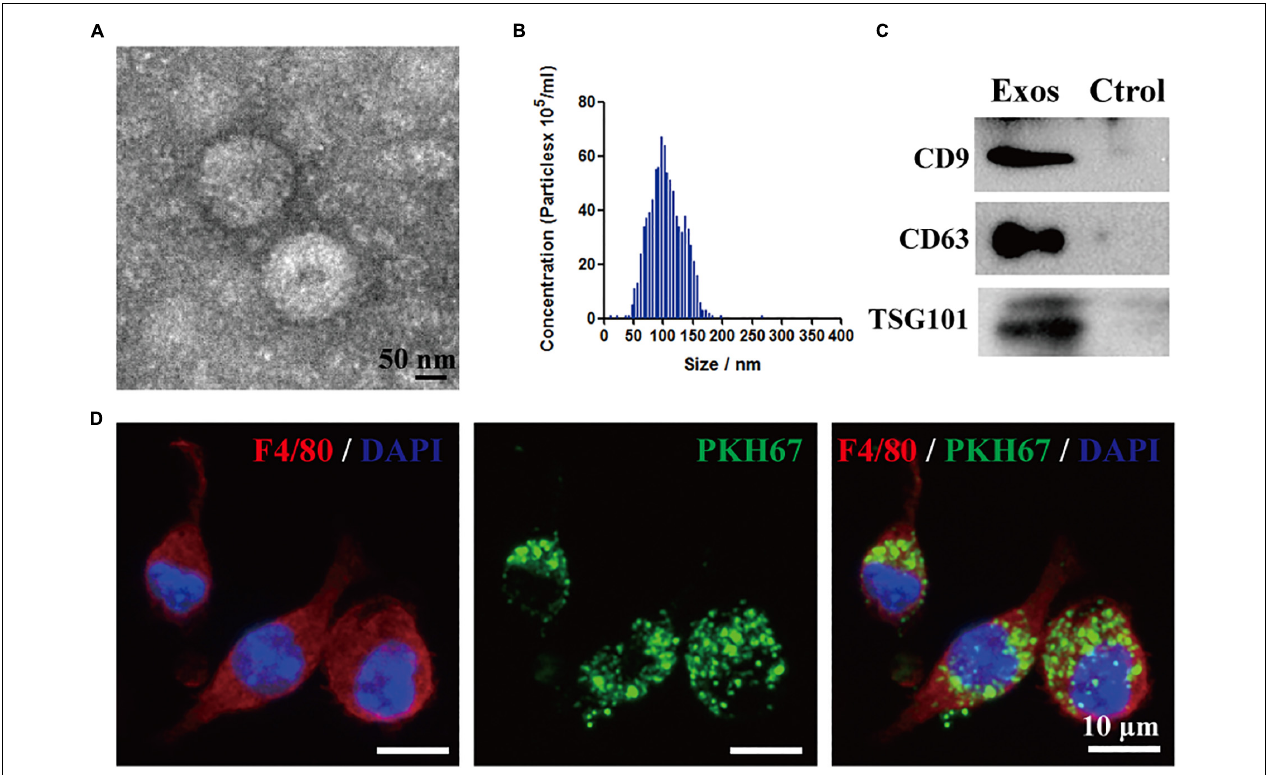
FIGURE 1 | Identification of bone marrow mesenchymal stem cell-derived exosomes (BMSC-Exos) and BMSC-Exos uptake by macrophages in vitro . (A) Representative transmission electron microscopy (TEM) image of Exos. Scale bar = 50 nm. (B) Nanoparticle tracking analysis (NTA) of the Exos diameter and particle number. (C) Western blotting analysis of the exosome-specific markers CD63, CD9 and TSG101. (D) Representative immunofluorescence image of Exos (PKH67 labeled, green) uptake by macrophages (F4/80, red). Nuclei were counterstained with DAPI (blue). Scale bar = 10 µ m. Exos, bone marrow mesenchymal stem cell-derived exosomes; Ctrol,